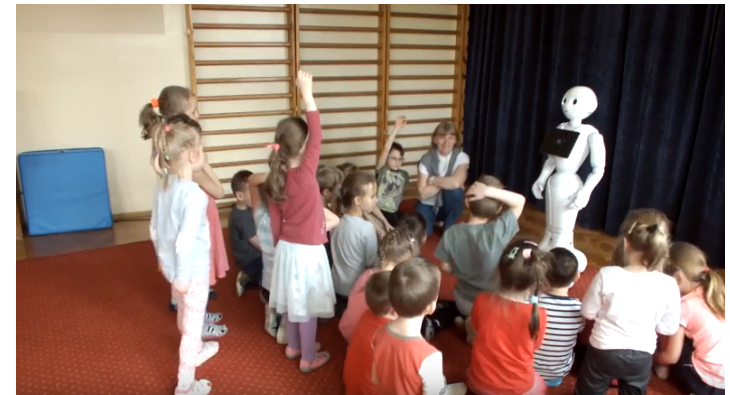
Figure 5. Polish